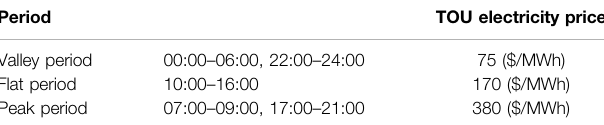
TABLE 2 | TOU electricity